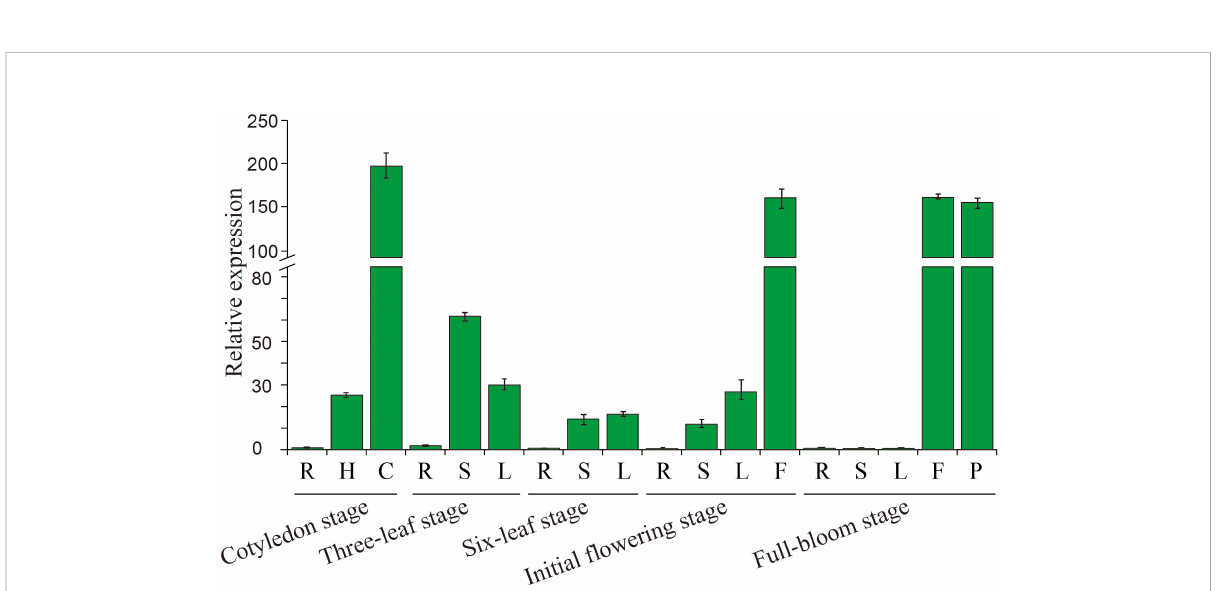
FIGURE 3 Expression analysis of BcGRP23 in different tissues at various developmental stages. R , root; H , hypocotyl; C , cotyledon; S , stem; L , leaf; F , fl ower; P , pod. Bar on top of the columns represents the standard